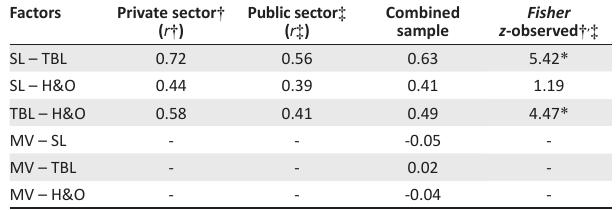
TABLE 2: Descriptive statistics of the variables and reliability coefficients of the instruments (across the sectors). Factor